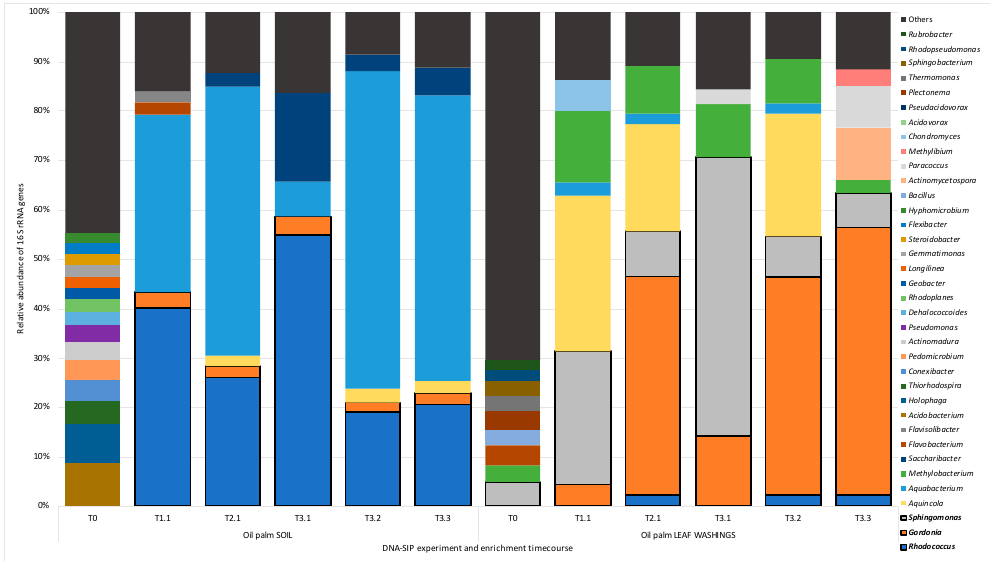
Figure 1. Relative abundance of bacterial genera during DNA-stable isotope probing (DNA-SIP) enrichments. Figure 1 shows the relative abundance of bacterial 16S rRNA genes (at the genus level), obtained by PCR of enriched and un-enriched DNA extracted from oil palm soil samples and leaf washings. Results include un-enriched (un-fractionated) samples and heavy DNA fractions (Figure S3) for three time points T 1 , T 2 for one replicate (shown as T1.1, T2.1) and T 3 for all three replicates (shown as T3.1, T3.2, and T3.3; refer to Table S1 for the time course). Only 16S rRNA gene sequences with a relative abundance of greater than 2% or over are shown. 16S rRNA gene sequences with a relative abundance of less than 2% are grouped together as “others.” Sequences from the genera ( Rhodococcus , Gordonia , and Sphingomonas ), highlighted with a black border, were identified as putative isoprene-degrading bacteria according to 13 C-labelling.